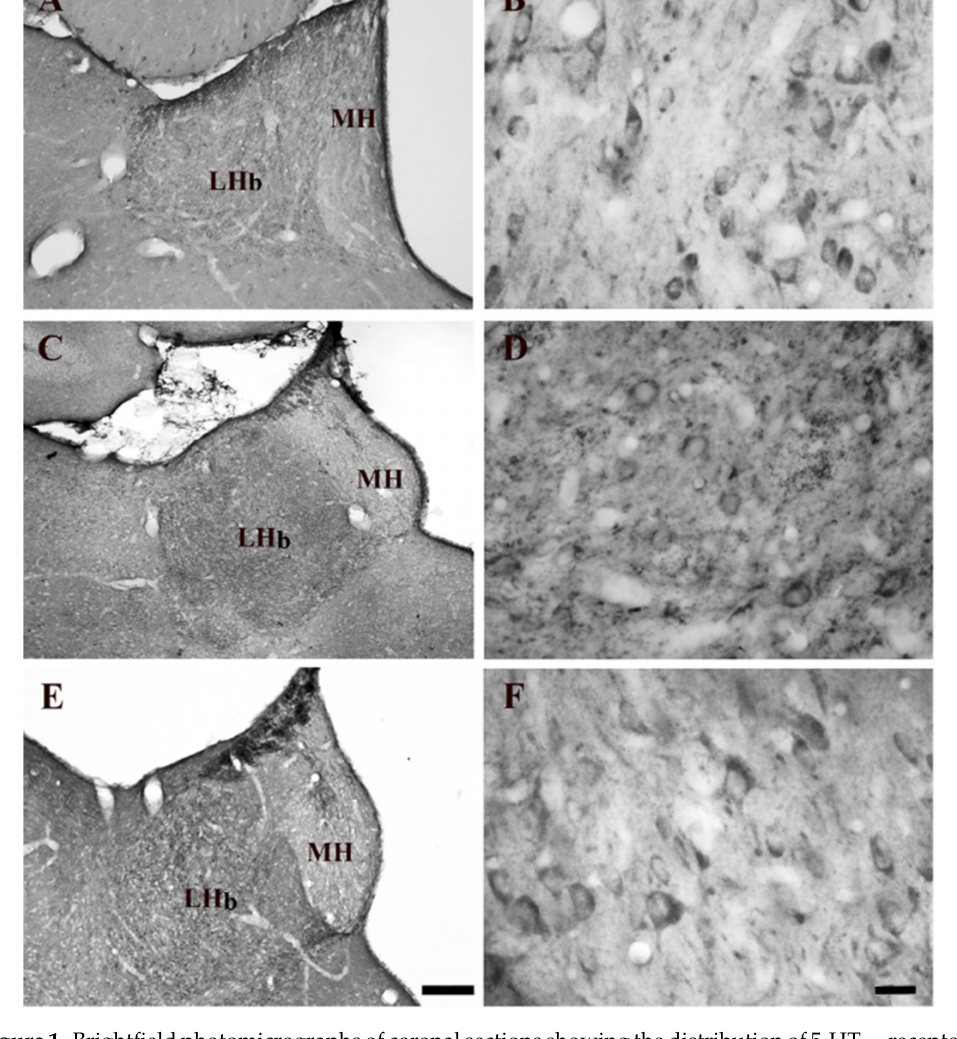
Figure 1. Brightfield photomicrographs of coronal sections showing the distribution of 5-HT 2A receptors (5-HT 2A Rs) immunoreactivity in the lateral habenula (LHb) of nicotine-naïve ( A , B ), acute nicotine ( C , D ), and chronic nicotine ( E , F ). Note the high 5-HT 2A R immunoreactivity in the LHb of acute nicotine rats ( C ). See text and Table 1 explanations. Abbreviations: LHb, lateral habenula; MH, medial habenula. Scale bar = 200 µ m in E (applies to A , C , E ) and 20 µ m in F (applies to B , D , F